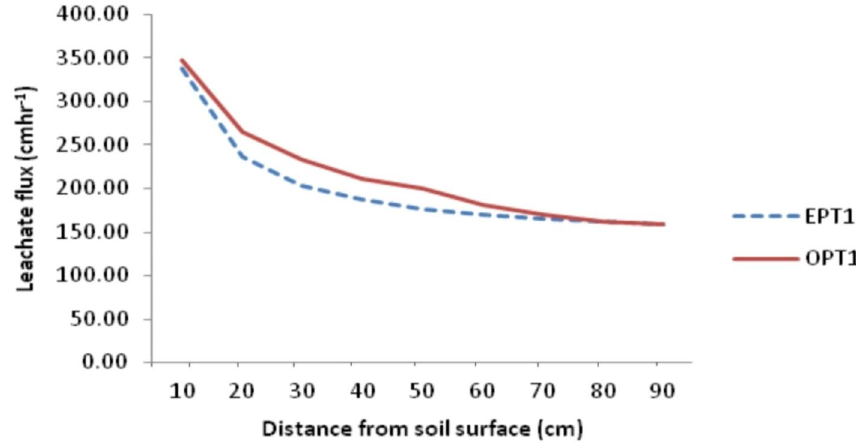
Figure 6. Pattern of observed and estimated leachate flux at PT01 in the dumpsite soil.